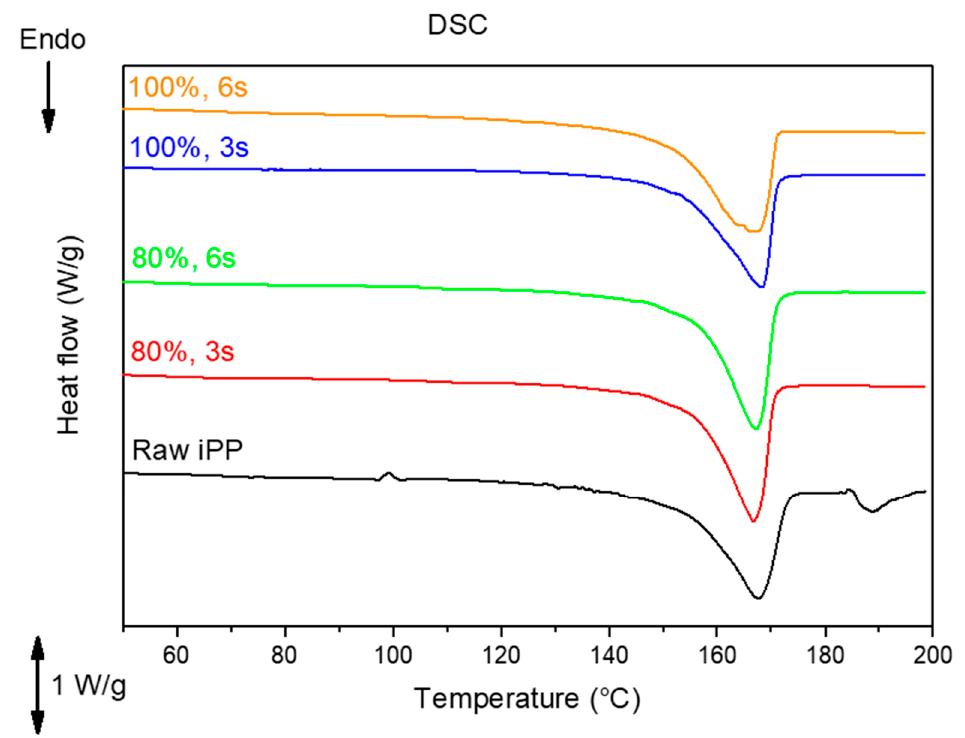
Figure 11. DSC thermograms of specimens fabricated through the UMIM process. For simplicity, only the samples with the lowest and highest of the varied parameters amplitude and time were analyzed.